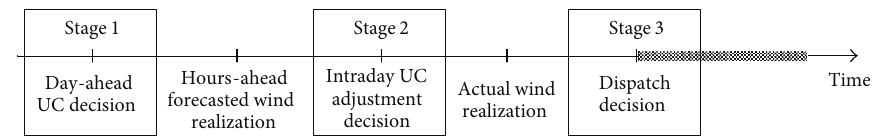
Figure 1: Timeline of proposed three-stage decision